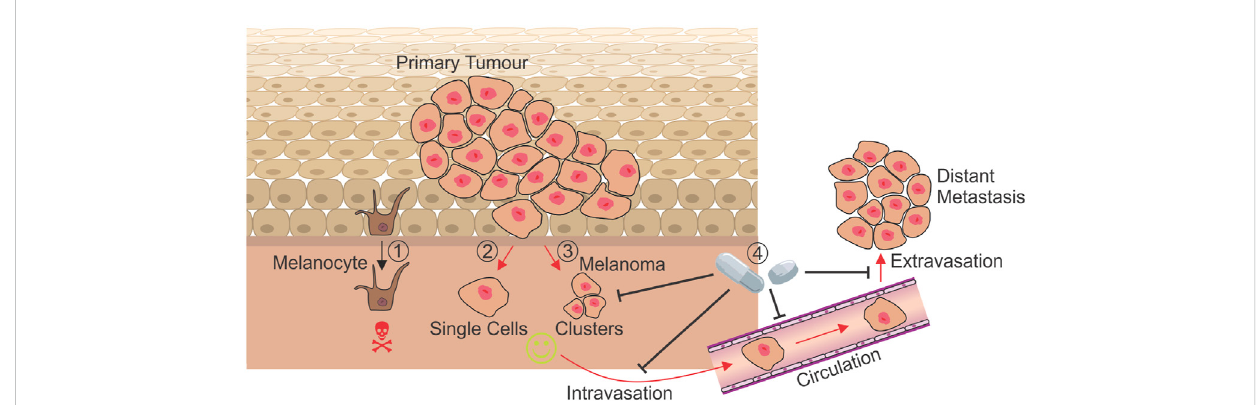
FIGURE 1 Mechanisms of anoikis resistance during metastasis. While the detachment of a non-transformed melanocyte results in cell death by anoikis (1), melanoma cells leaving the dermis as either single cells (2) or clusters (3) must develop mechanisms to resist anoikis in order to metastasise and form secondarytumoursatdistantsites.Treatmentstargetingcurrentlyknownmechanismsofanoikisresistancehavethepotentialtopreventcellsleavingthe primary tumour (4), and may target those in circulation, preventing the seeding of metastases and improving prognosis for patients. Red arrows: Processes where anoikis resistance is absolutely